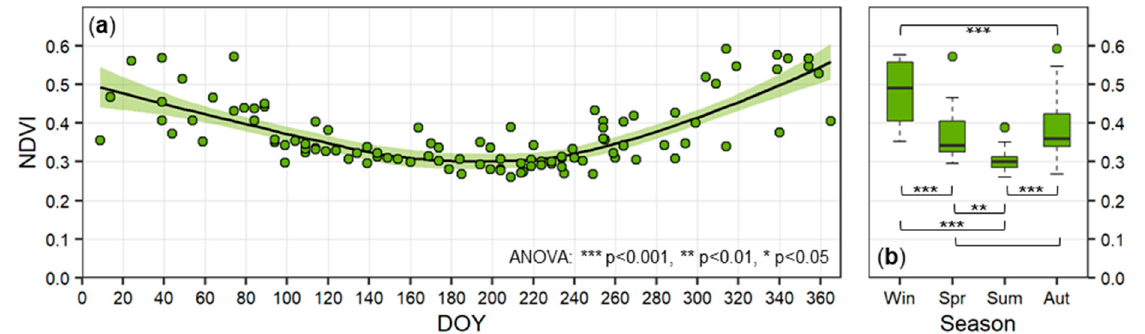
Figure 9. Time series of averaged Sentinel-2 NDVI grids referring to the metabolic activity of BSCs for each day-of-year (DOY) during one aggregated year including a polynomial trendline ( a ) and boxplots exhibiting the range of these aggregated NDVI values for each season ( b ). The significance of the difference between the seasons was determined using one-way ANOVA. The asterisks indicate the level of significance (*** p < 0.001, ** p < 0.01, * p < 0.05).